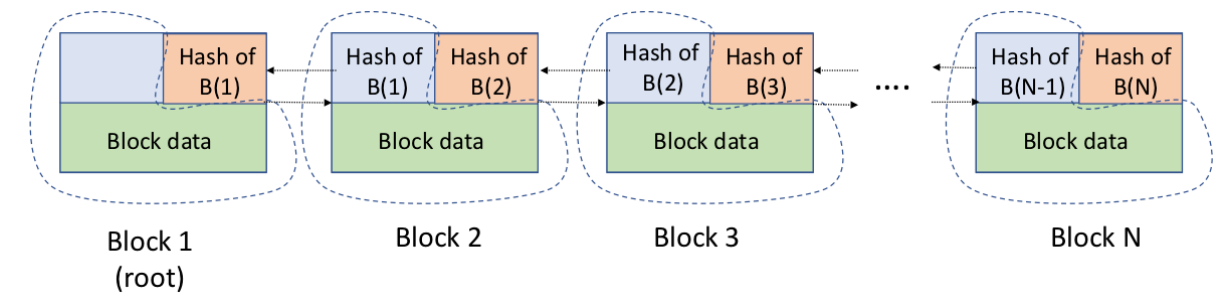
Figure 1. Simple